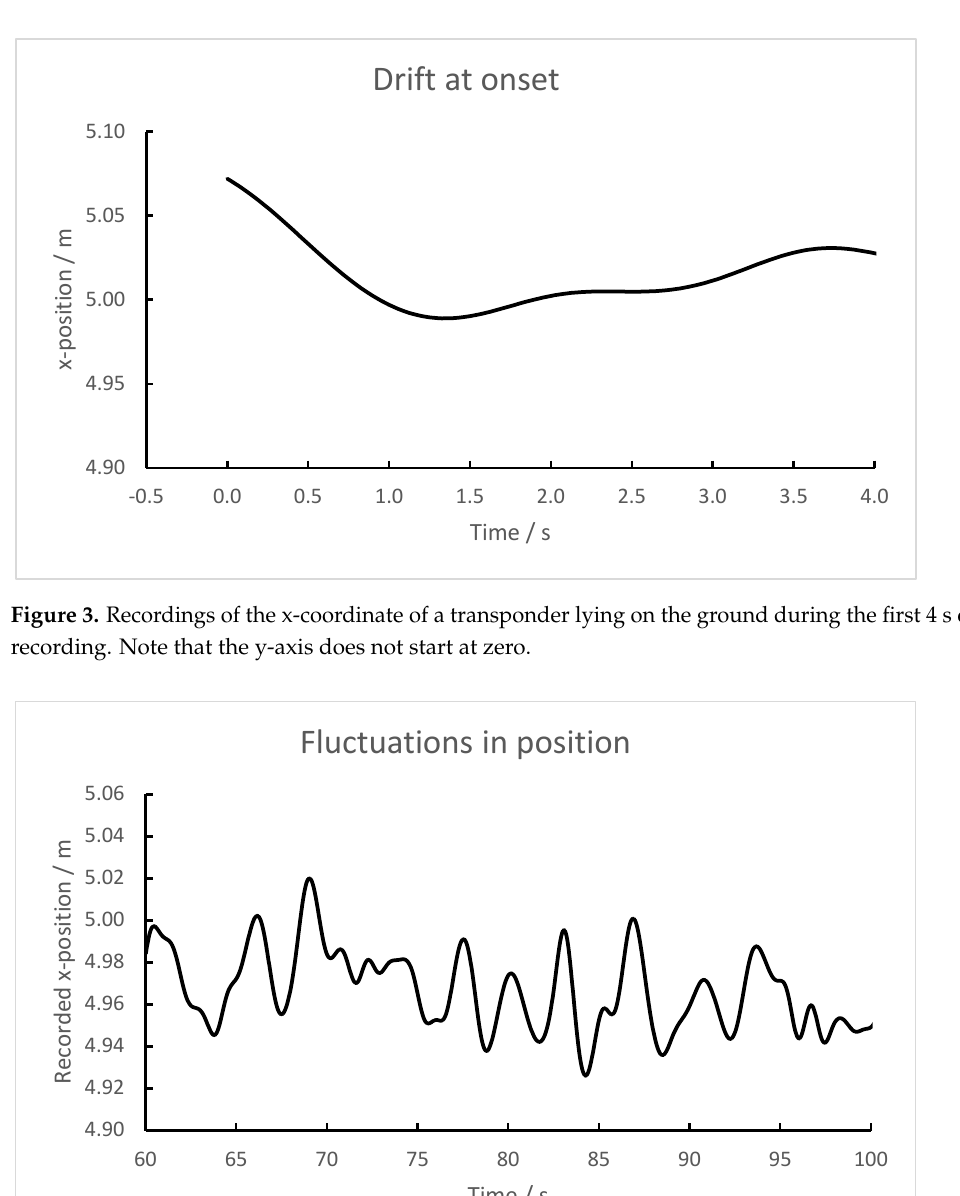
Figure 3. Recordings of the x ‐ coordinate of a transponder lying on the ground during the first 4 s of a recording. Note that the y ‐ axis does not start at zero.